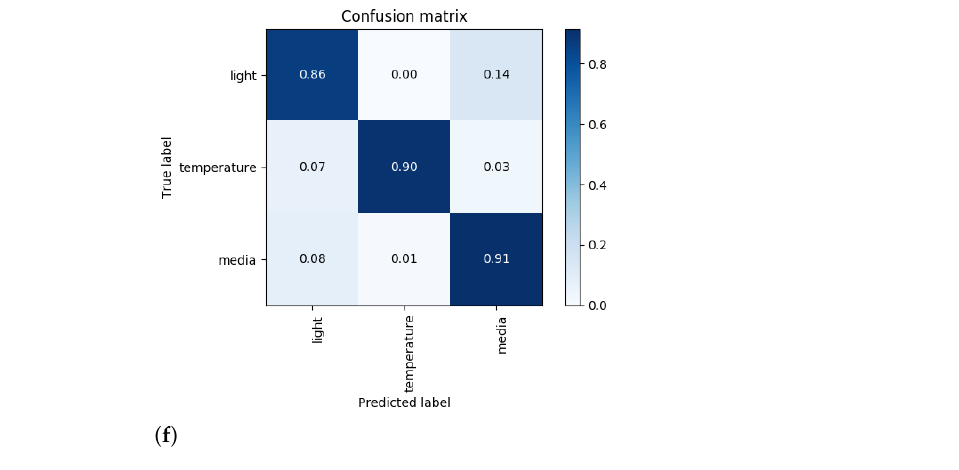
Figure A6. Intent confusion matrices ( a ) Scenario 2 ( b ) Scenario 2 Super-class confusion ( c )